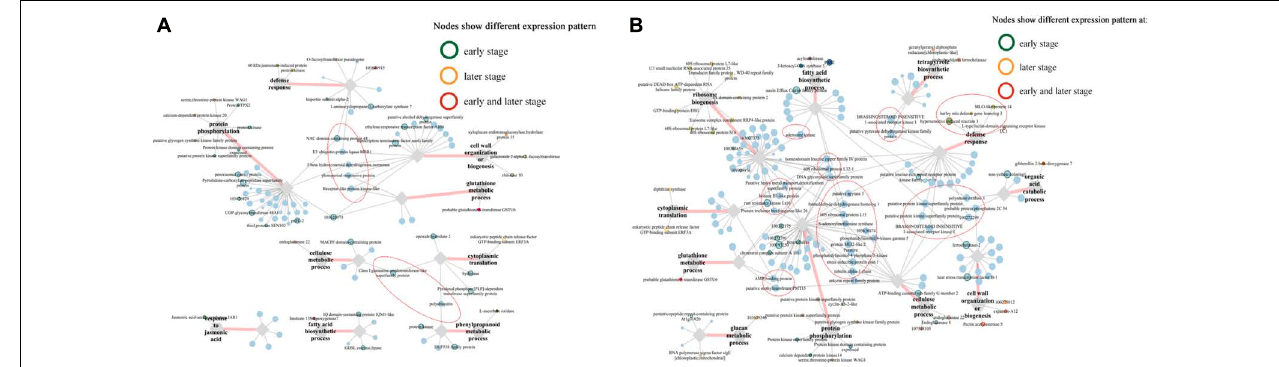
FIGURE 7 | Co-expression networks of top 5 genes co-expressed with pray genes, specifically correlated with F. graminearum biomass in (A) A08 and (B) K09, constructed by WGCNA. The gray hexagons on the graph represent pray genes grouped by GO terms, and each node linked between hexagons represents genes in corresponding GO term; the wider the line, the higher connectivity the genes. The nodes linked with diamond represent genes co-expressed with pray genes grouped by GO terms. Genes in red dashed ellipse represent “hub genes” that co-expressed with more than one group of pray genes, and nodes with colored border indicate different expression patterns between two